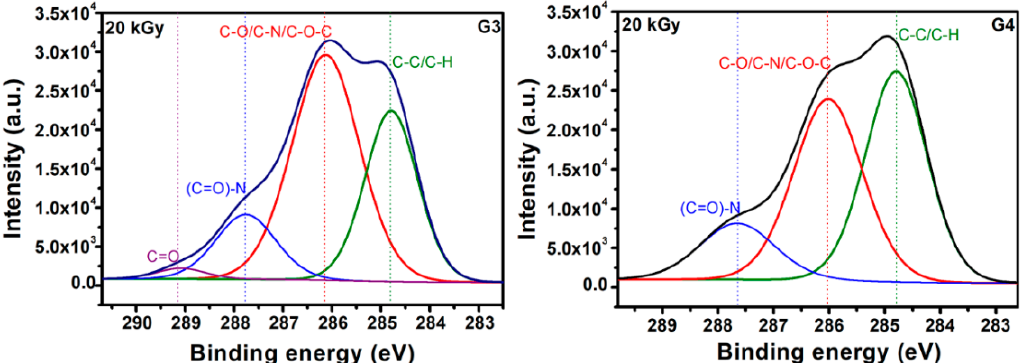
Figure 7. Chemical bonds as evidenced upon deconvolution of C1s high resolution spectra for G3 hydrogels and respectively G4 hydrogels.